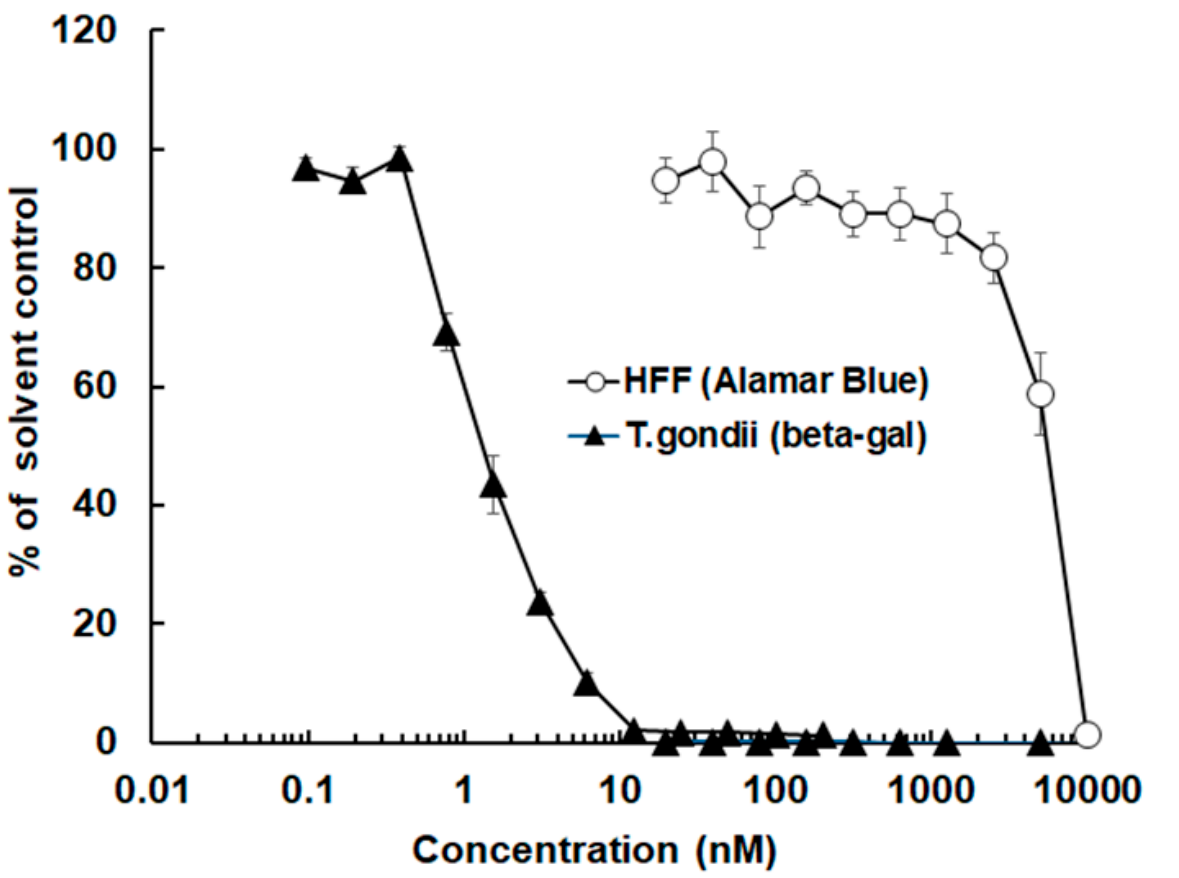
Figure 1. The antimicrobial peptide 6027 inhibits Toxoplasma gondii at nanomolar concentrations. The inhibition of T. gondii RH tachyzoite proliferation was determined using a beta-galactosidase reporter strain in the presence of a concentration series of peptide 6027 added prior to the infection of confluent HFF by tachyzoites. The impact of peptide 6027 on the vitality of uninfected HFF was assessed via resazurin reduction. Mean values ± SE are indicated for quadruplicates. The x-axis scale is logarithmic at basis 10.